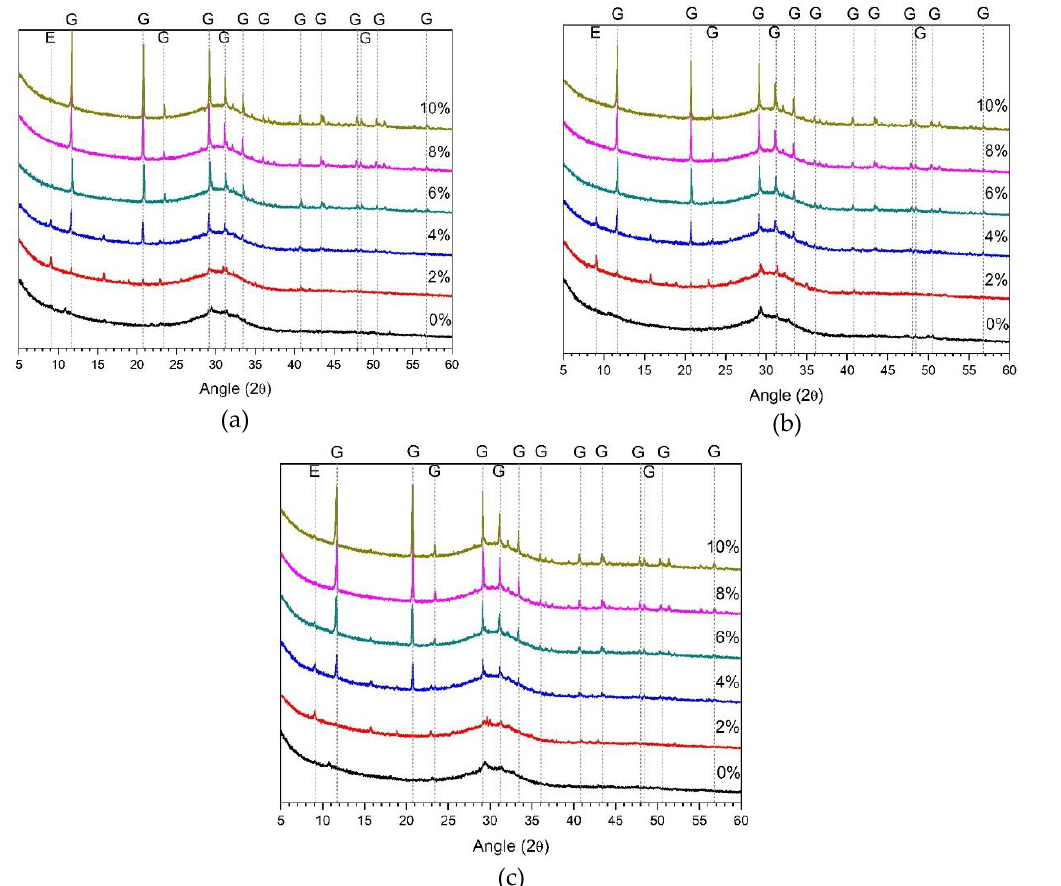
Figure 3. XRD analysis of ALS-only samples (without alkali) at ( a ) day 1, ( b ) day 3, and ( c ) day 28. E: ettringite; G: gypsum. ettringite; G: